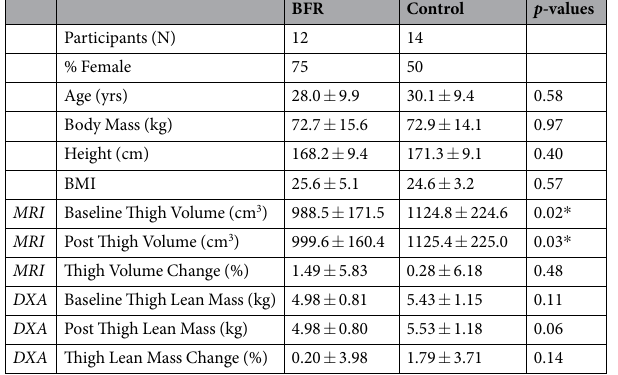
Table 1. Participant Characteristics. BFR, blood flow restricted experimental group; BMI, body mass index; DXA, dual-energy X-ray absorptiometer; MRI, magnetic resonance imager; * significant difference between BFR and control group.